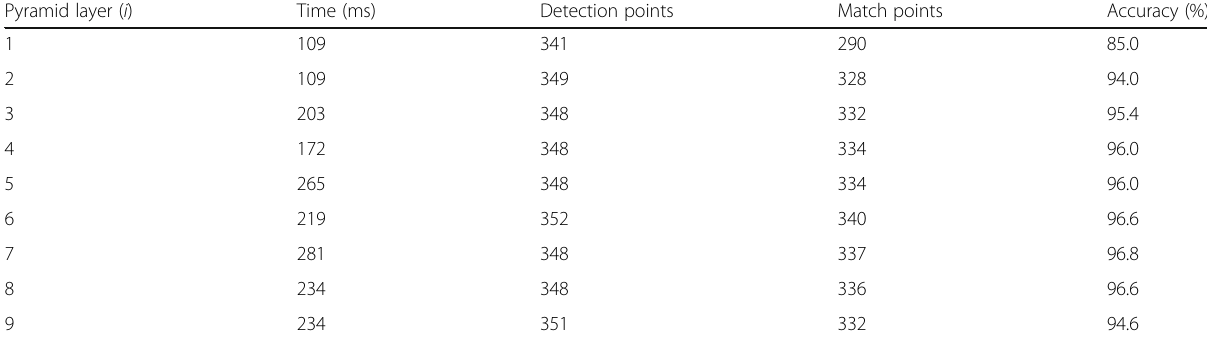
Table 4 Statistical results of experimental results when the scale parameter of the pyramid image is 1.1 Pyramid layer ( i )